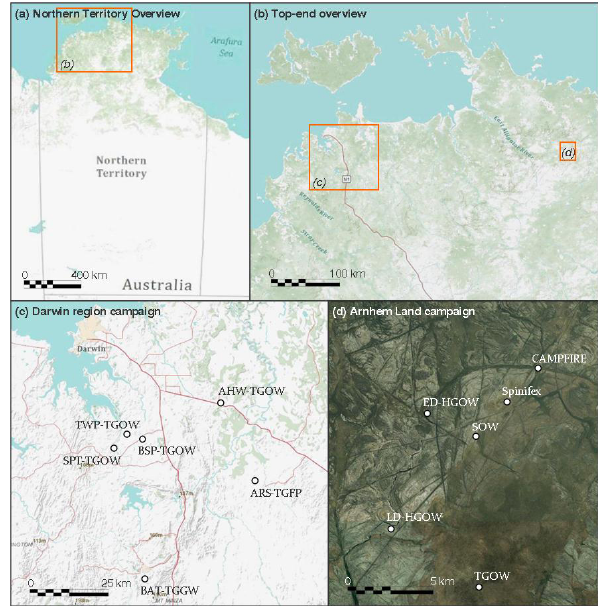
Figure 4. Maps showing the location of each of the fire sites dis- cussed in this paper (see Table 1 for full site